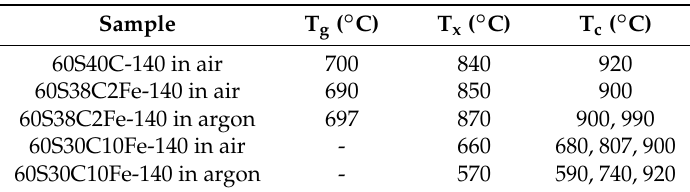
Table 3. Characteristic temperatures of non-calcined materials determined (when possible) from DSC plots.